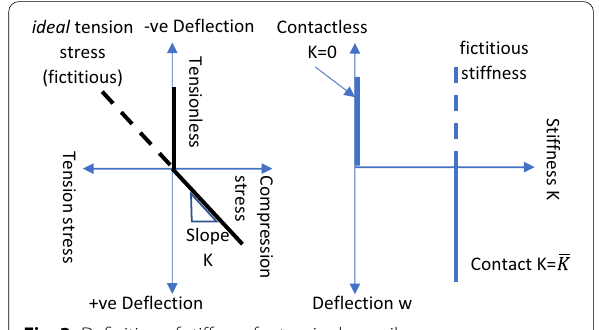
Fig. 3 Definition of stiffness for tensionless